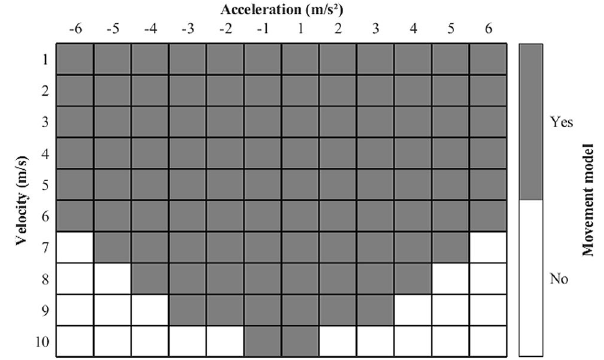
Figure 4. Matrix chart representation of the velocity and acceleration data samples that were used to create their specific movement models according to each range, the combination of velocity and acceleration ranges that generated a movement model are indicated by the gray cells.